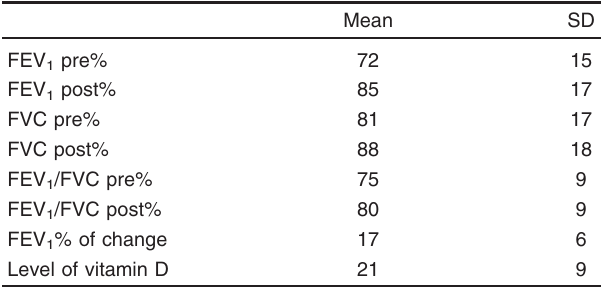
Table 4 The correlation between the vitamin D level and the severity of asthma for age